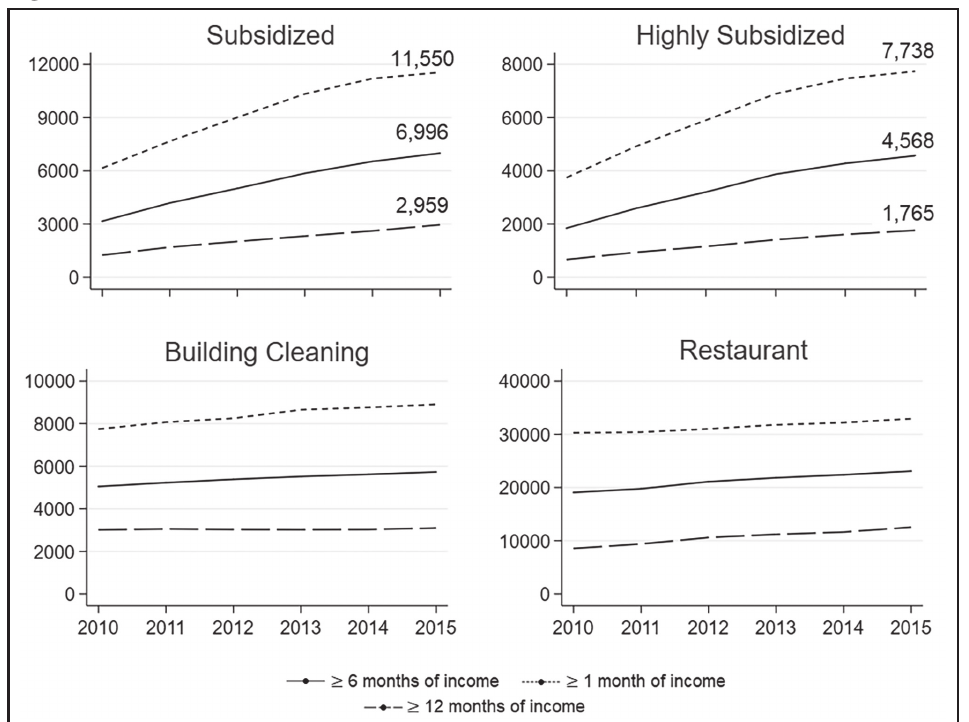
Figure W5 Number of small business owners.